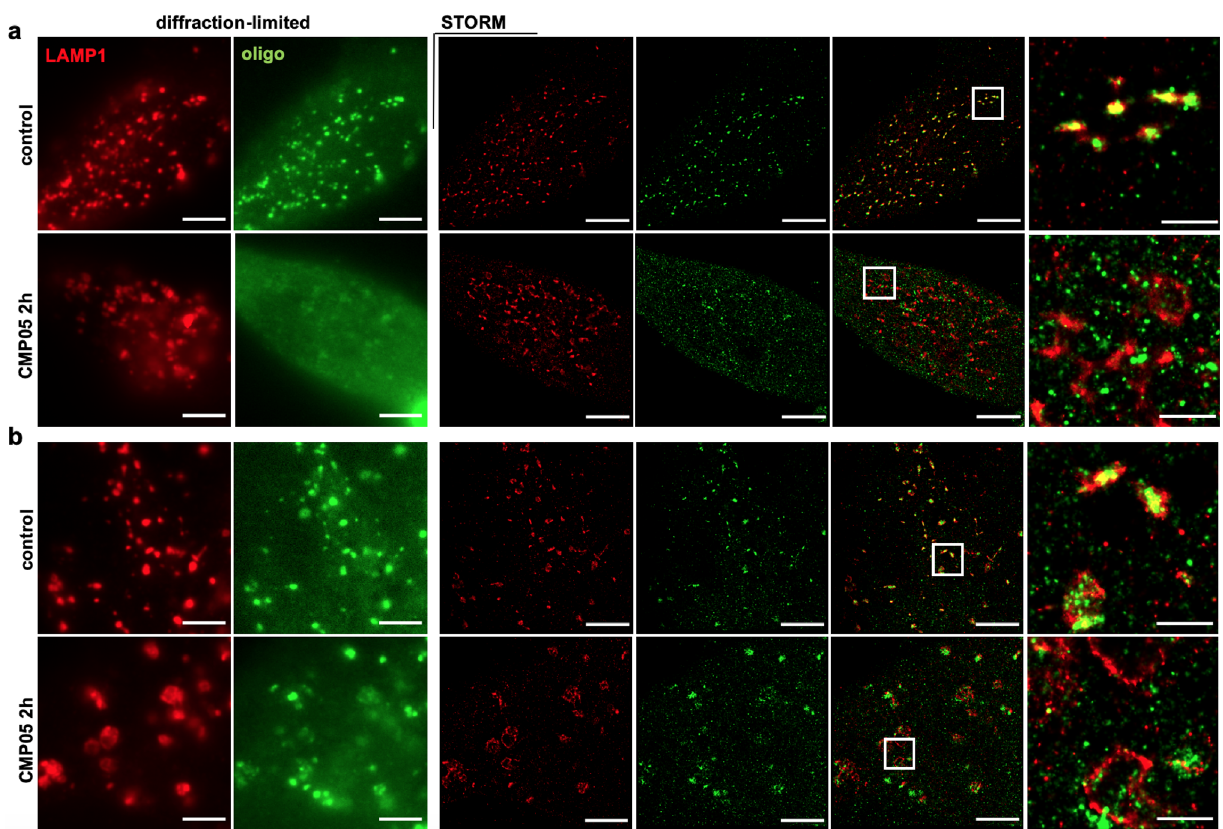
Fig. 5 STORM imaging of SSO traf fi cking in CMP05-treated HeLa and HuH7 cells. a Diffraction-limited and STORM images of lysosomes (red; LAMP1 ICC) and Alexa-Fluor 488-labeled SSO (green) in control HeLa cells and after 2 h treatment with 5 µ M CMP05. Scale bars 5 µ m, except in the zoomed area 1 µ m. b Diffraction-limited and STORM images of lysosomes (red; LAMP1 ICC) and Alexa-Fluor 488-labeled SSO (green) in control HuH7 cells and after 2 h treatment with 2.5 µ M CMP05. Scale bars 5 µ m, except in the zoomed area 1 µ